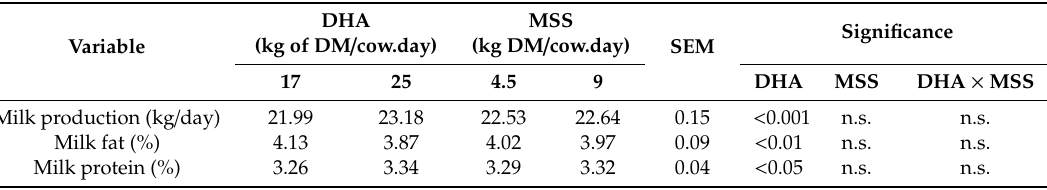
Table 6. E ff ects of daily herbage allowances (DHA) and level of maize silage supplementation (MSS) on milk production levels and milk compositions of autumn-calving dairy